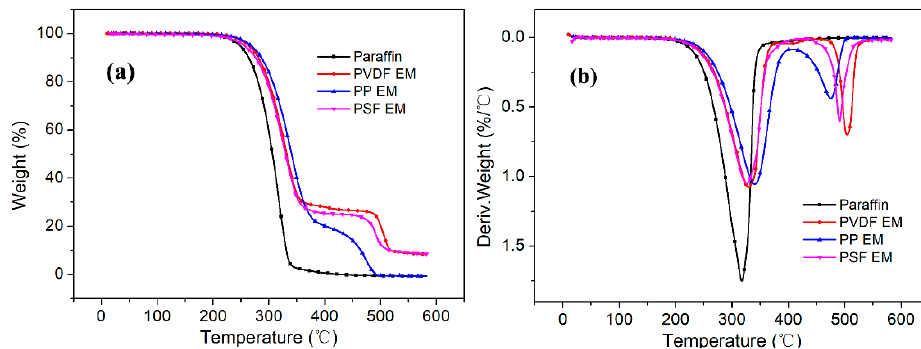
Figure 9. TGA curves ( a) and DTG curves ( b) of paraffin and three encapsulation membranes.